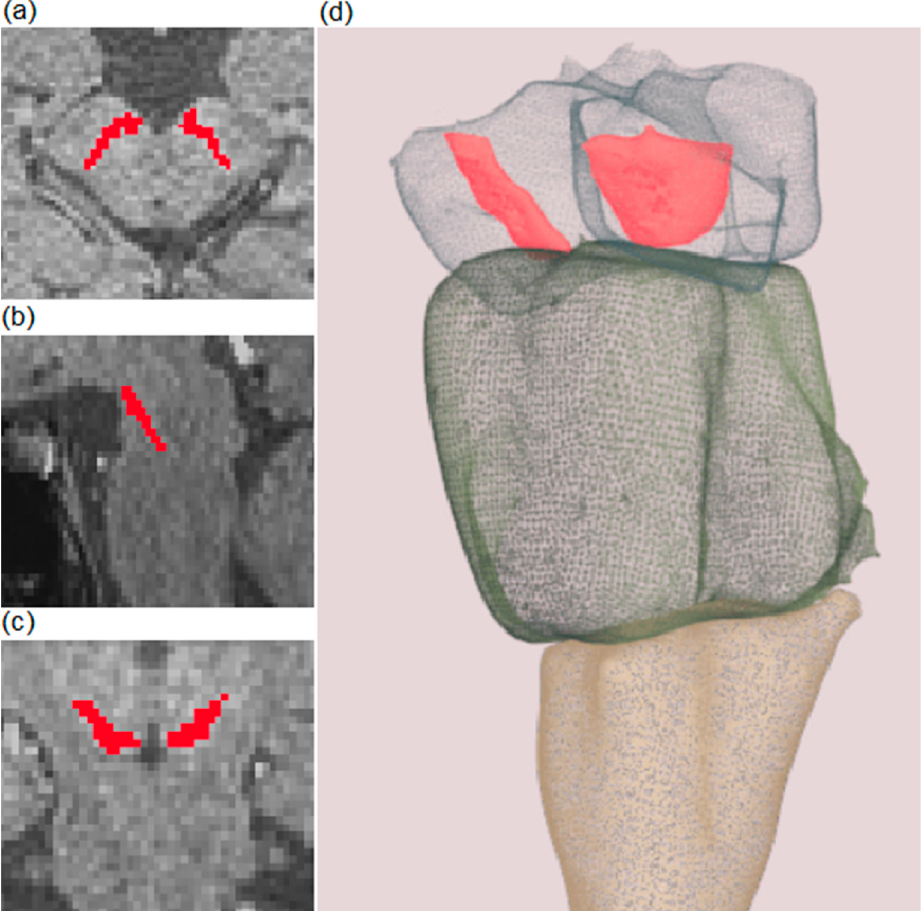
Figure 4. Example of semi-automatic segmentation of a substantia nigra (SN) on T1-weighted spectral pre-saturation with inversion recovery (SPIR) images. Red-colored areas represent segmented SN. Transverse, sagittal, and coronal planes are presented in ( a ), ( b ), and ( c ), respectively. A 3D model of the brainstem (presented as a transparent structure for better visualization) and SN (colored in red) are shown in ( d ). A full example of the 3D model is included in Supplementary files.